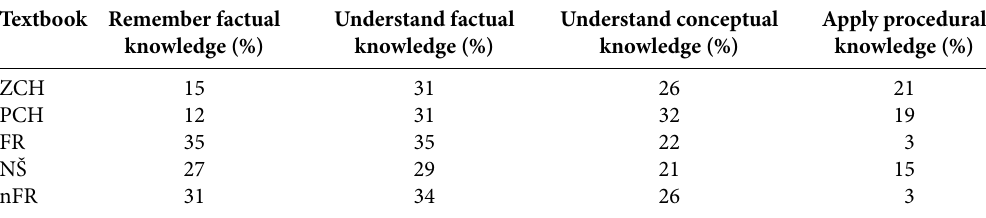
Table 6. Most frequent tasks in textbooks Textbook Remember